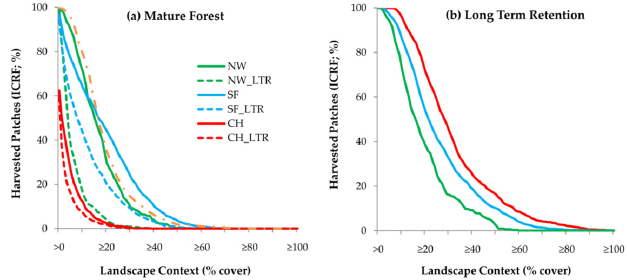
Figure 6. Inverse cumulative relative frequency (ICRF; %) of harvested patches at different levels of surrounding mature forest cover (i.e., landscape context) for three study areas (Southern Forests Tasmania (SF); North West Tasmania (NW); Central Highlands Victoria (CH)). Landscape context is the percentage cover of ( a ) structurally mature forest or ( b ) long ‐ term retention (of any age) within a 1000 m buffer around the perimeter of a harvested patch. In ( a ) ICRF curves were calculated for (i) structurally mature forest patches (no suffix) and (ii) structurally mature forest patches in long ‐ term retention (_LTR). In Victoria, ICRF curves were also generated for 1939 regrowth in long ‐ term retention (CH_1939_LTR). For example: in ( a ), 44% of mature forest patches in Southern Forests Tasmania had more than 20% mature forest cover in the surrounding 1000 m buffer.